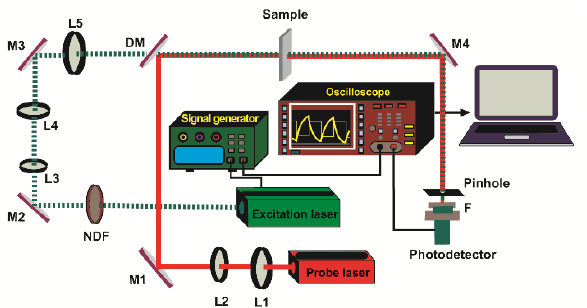
Figure 1. Scheme of the dual-beam mode-mismatched configuration. L1, L2, L3, L4, L5: lenses; M1, M2, M3, M4: turning mirrors; DM: dichroic mirror; NDF: neutral-density filter; F: filter.